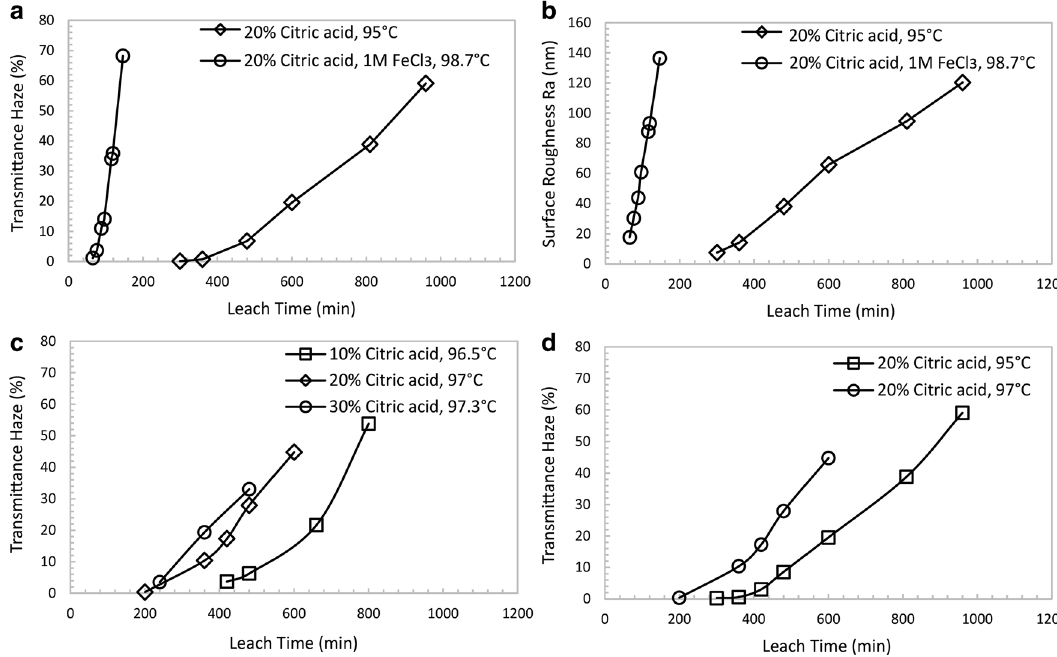
Figure 3. Process factors influencing differential leaching and texturing process using Glass A as examples. All glass articles were first treated in acid solutions and then washed in NaOH solution to reveal the textured glass surface. Surface roughness (Ra) was measured by AFM. Single-side transmittance haze values were measured by BYK Haze-Gard. ( a ), ( b ) The impact of leach time on surface haze development ( a ) and surface roughness development ( b ). Plots with diamond markers (◊) are the haze values ( a ) and roughness values ( b ) of textured Glass A treated in 20 wt% citric acid at 95 °C for different leach time. Plots with circle markers ( ○ ) present the haze development ( a ) and roughness development ( b ) of Glass A in 20 wt% citric acid and 1 M FeCl 3 at 98.7 °C for different leach time. Both plots confirm the differential leaching process contains a uniform leaching stage without haze (Stage I in Fig. 1 diagram b) and a differential leaching stage (stage II in Fig. 1 diagram b) with rapid haze growth. The usage of FeCl 3 significantly accelerates the texturing process. c , The impact of citric acid concentration on haze development. Glasses were textured in 10 wt% (labelled as square markers: □ ), 20 wt% (labelled as diamond markers: ◊), and 30 wt% (labelled as circle markers: ○ ) citric acid solutions at 96.5 °C, 97 °C, and 97.3 °C, respectively. Glass texturing process is shortened by increasing citric acid concentration. d , The impact of leach temperature on haze development. Glasses were textured in 20 wt% citric acid at 95 °C (square markers: □ ) and 97 °C (circle markers: ○ ). Data show that increasing treatment temperature promotes a quicker texturing